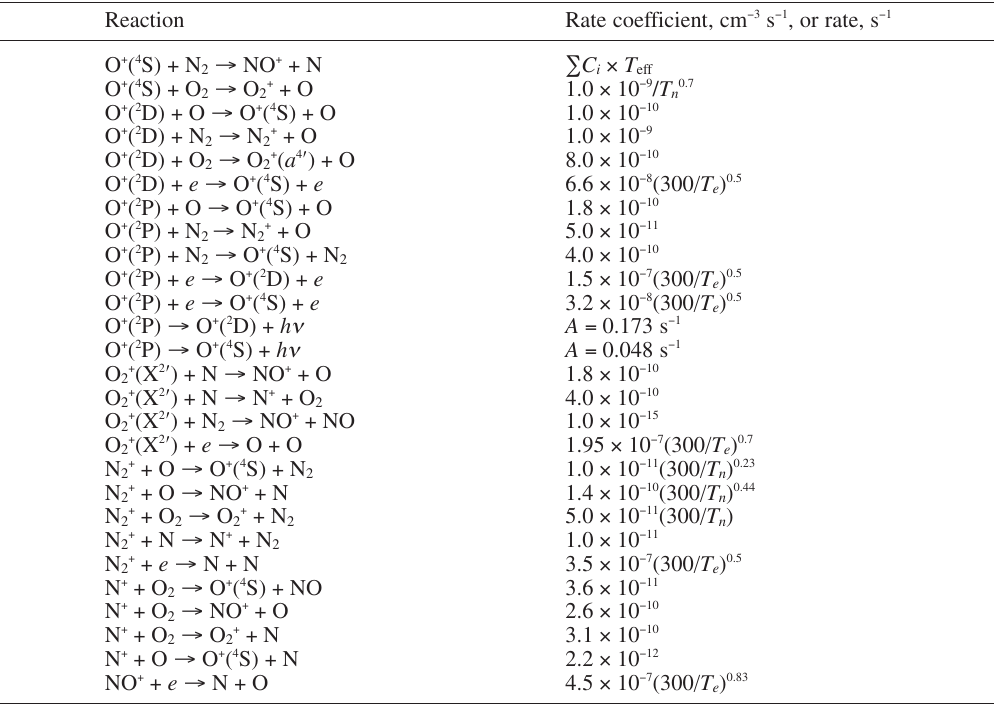
Table 4.I. Chemical reactions used in the